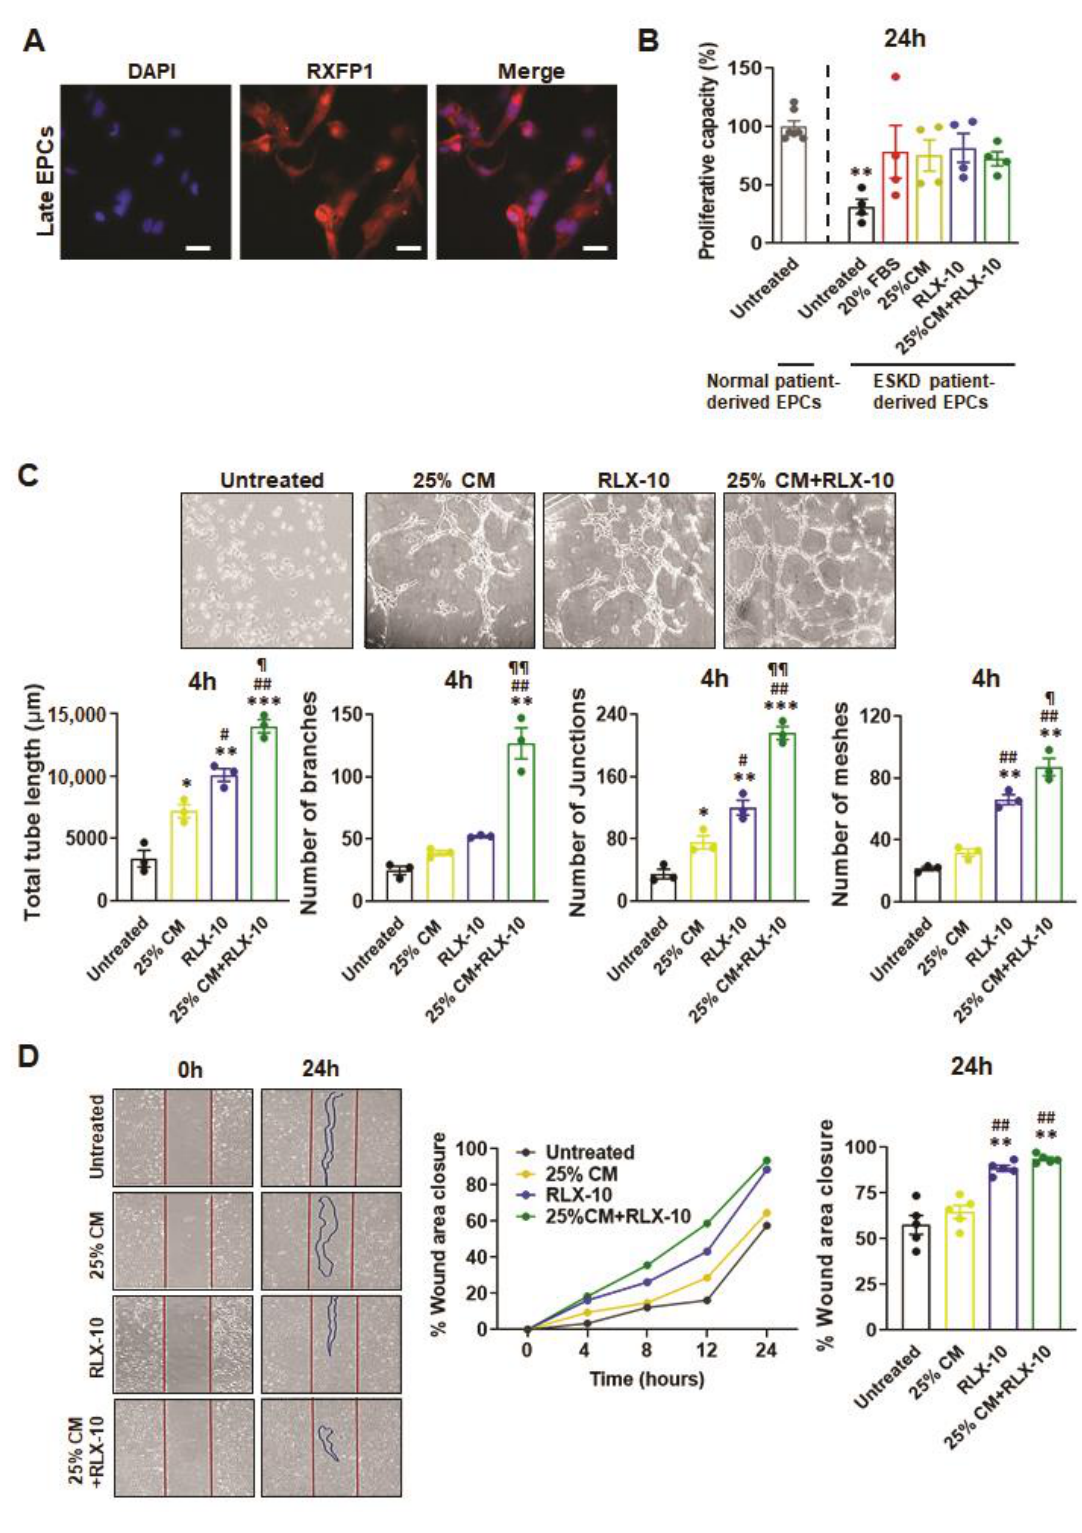
Figure 2. The effects of BM-MSC-derived CM and/or RLX on stage V ESKD patient-derived EPC viability/proliferation, angiogenesis and wound healing. Late EPCs derived from the blood of male ESKD patients were also found to express RXFP1; scale bar = 50 µm ( A ). EPC proliferation after 24 hours (24 h) was determined from n = 4 patient-derived EPCs per group in response to 20% FBS (positive control), 25% BM-MSC-CM (25% CM), RLX [10 ng/mL (RLX-10)] or the combined effects of 25% CM+RLX-10. Data from untreated EPCs derived from healthy male patients (presented in Figure 1B) are also included for comparison ( B ). EPC-mediated tube formation (determined from